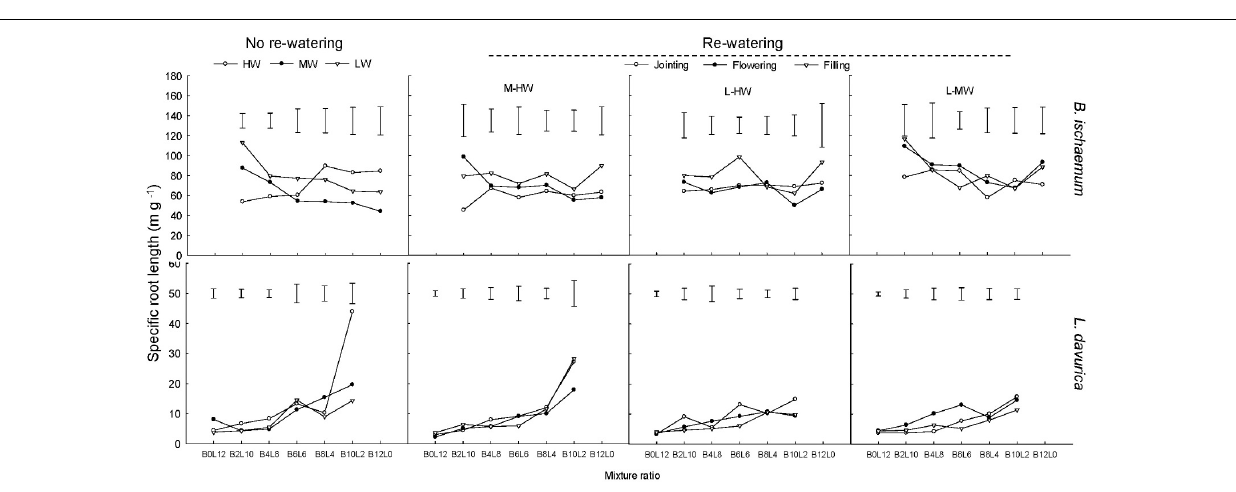
FIGURE 5 | Specific root length (SRL) of B. ischaemum (B) and L. davurica (L) at various mixture ratios under each water treatment. HW: 80 ± 5% FC; MW: 60 ± 5% FC; LW: 40 ± 5% FC; M-HW: soil water content increased from MW to HW; L-MW: soil water content increased from LW to MW; L-HW: soil water content increased from LW to HW. The vertical bars indicate the LSD values ( P ≤ 0.05) for the SRL difference of each species among water treatments at each mixture